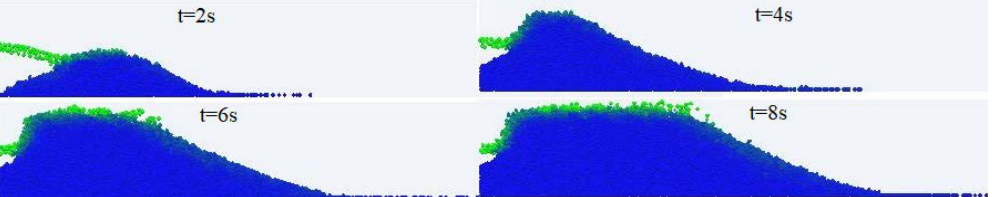
Figure 11. Distribution of proppants along with fracture slot for horizontal well.